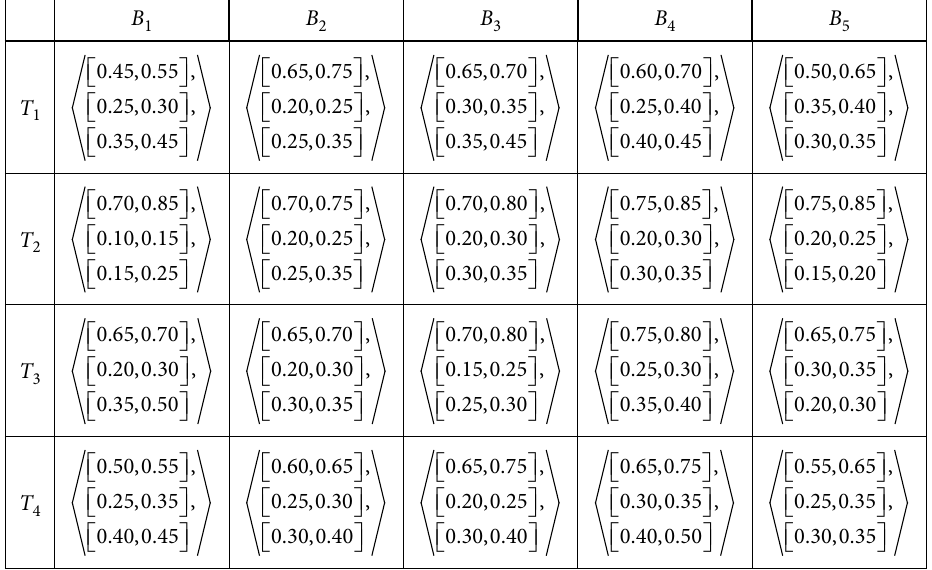
Table 5. Standardized decision